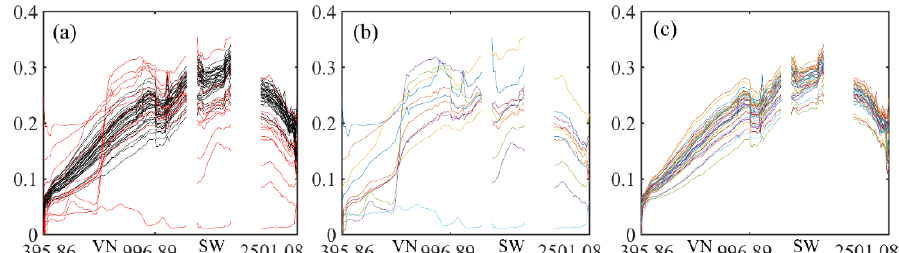
Figure 5. ( a ) ZY1-02D spectral reflectance of total 46 De sampling points; ( b ) Spectral reflectance with no bare soil characteristic; ( c ) Spectral reflectance of bare soil. Axis X indicates the spectral region (unit: nm), Axis Y indicates the value of reflectance.